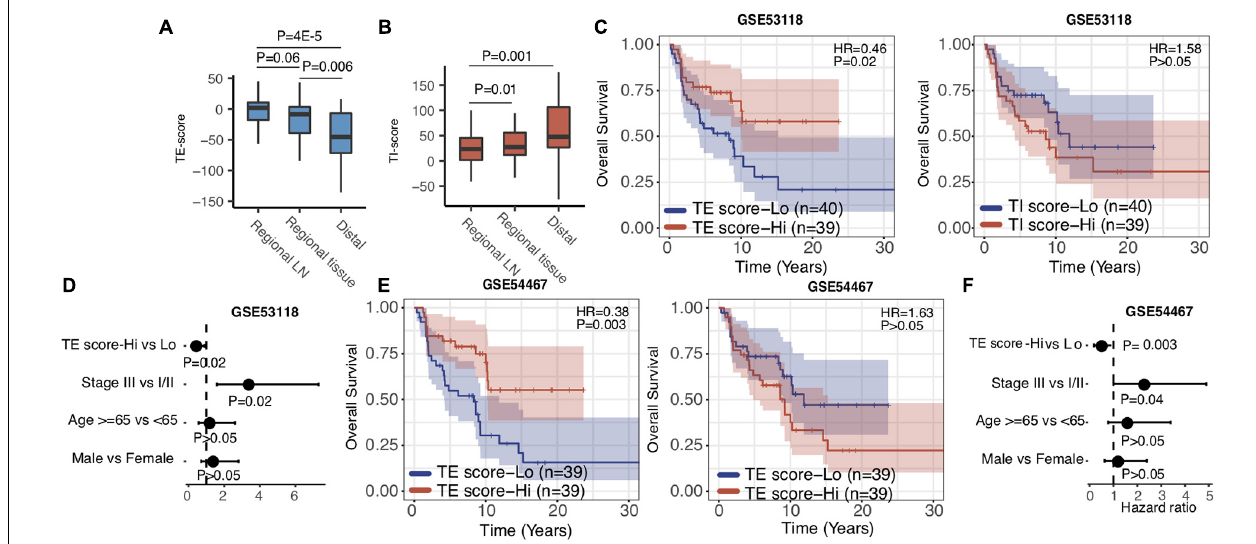
FIGURE 4 | TE signature predicts prognosis in stage III melanoma patients. (A,B) . Boxplots indicating the difference of TE-signature or TI-signature scores across different metastatic regions. P -values were calculated by the Wilcoxon rank-sum test. (C) Kaplan–Meier plots depicting the survival distribution for patients with high (red) and low (blue) TE-signature or TI-signature scores. (D) Forest plot showing hazard ratios and p -values of TE-signature scores and several clinical variables estimated by a multivariate Cox regression model. (E) Kaplan–Meier plots depicting the survival distribution for patients with high (red) and low (blue) TE-signature or TI-signature scores. (F) Forest plot showing hazard ratios and p -values of TI-signature score and several clinical variables estimated by a multivariate Cox regression model. In Kaplan–Meier plots, p -values were calculated using the log-rank test and vertical hash marks indicate censored data. In all forest plots, HR was presented as the 95% confidence interval, the dotted lines indicate the null association, and the Wald’s test was used to determine statistical